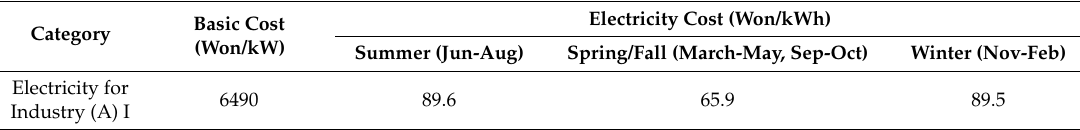
Table 3. Electricity